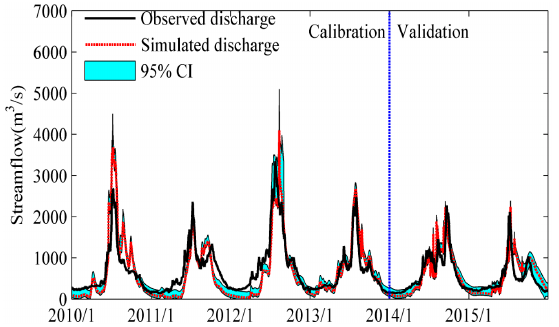
Figure 3. The 95% confidence interval (CI) for daily discharge.